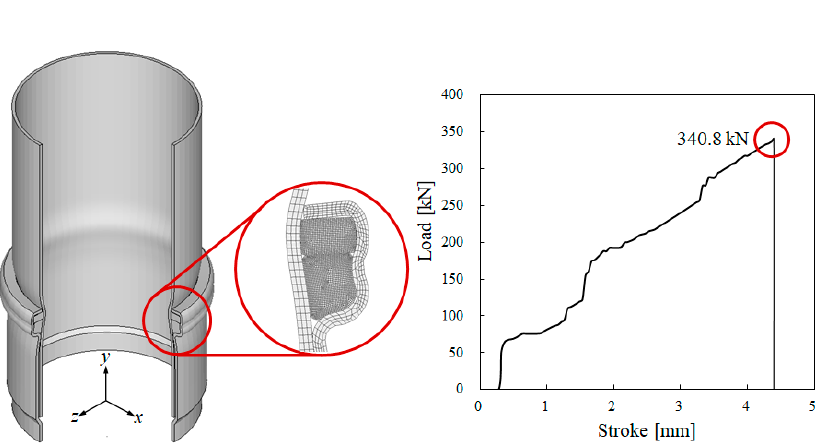
Figure 5. Numerical load–stroke curves of the conventional SR-joint